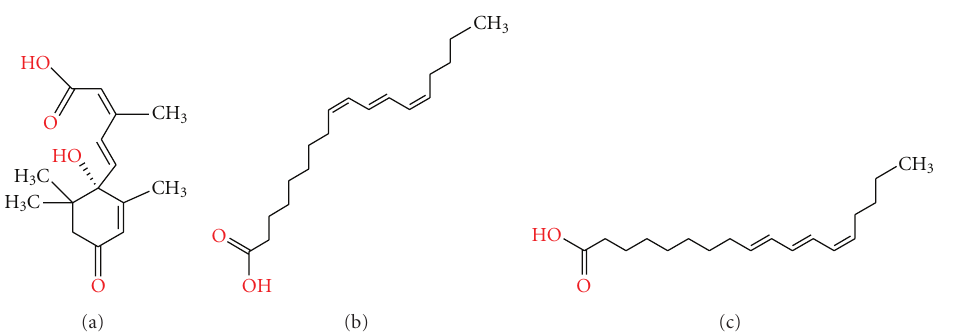
Figure 1: Chemical structures of the isoprenoid abscisic acid (a) and the conjugated linolenic acid stereo- or regioisomers punicic acid- (9 Z , 11 E , 13 E -) octadeca-9, 11, 13-trienoic acid (b) and catalpic acid- (9 E , 11 E , 13 Z -) octadeca-9, 11, 13-trienoic acid